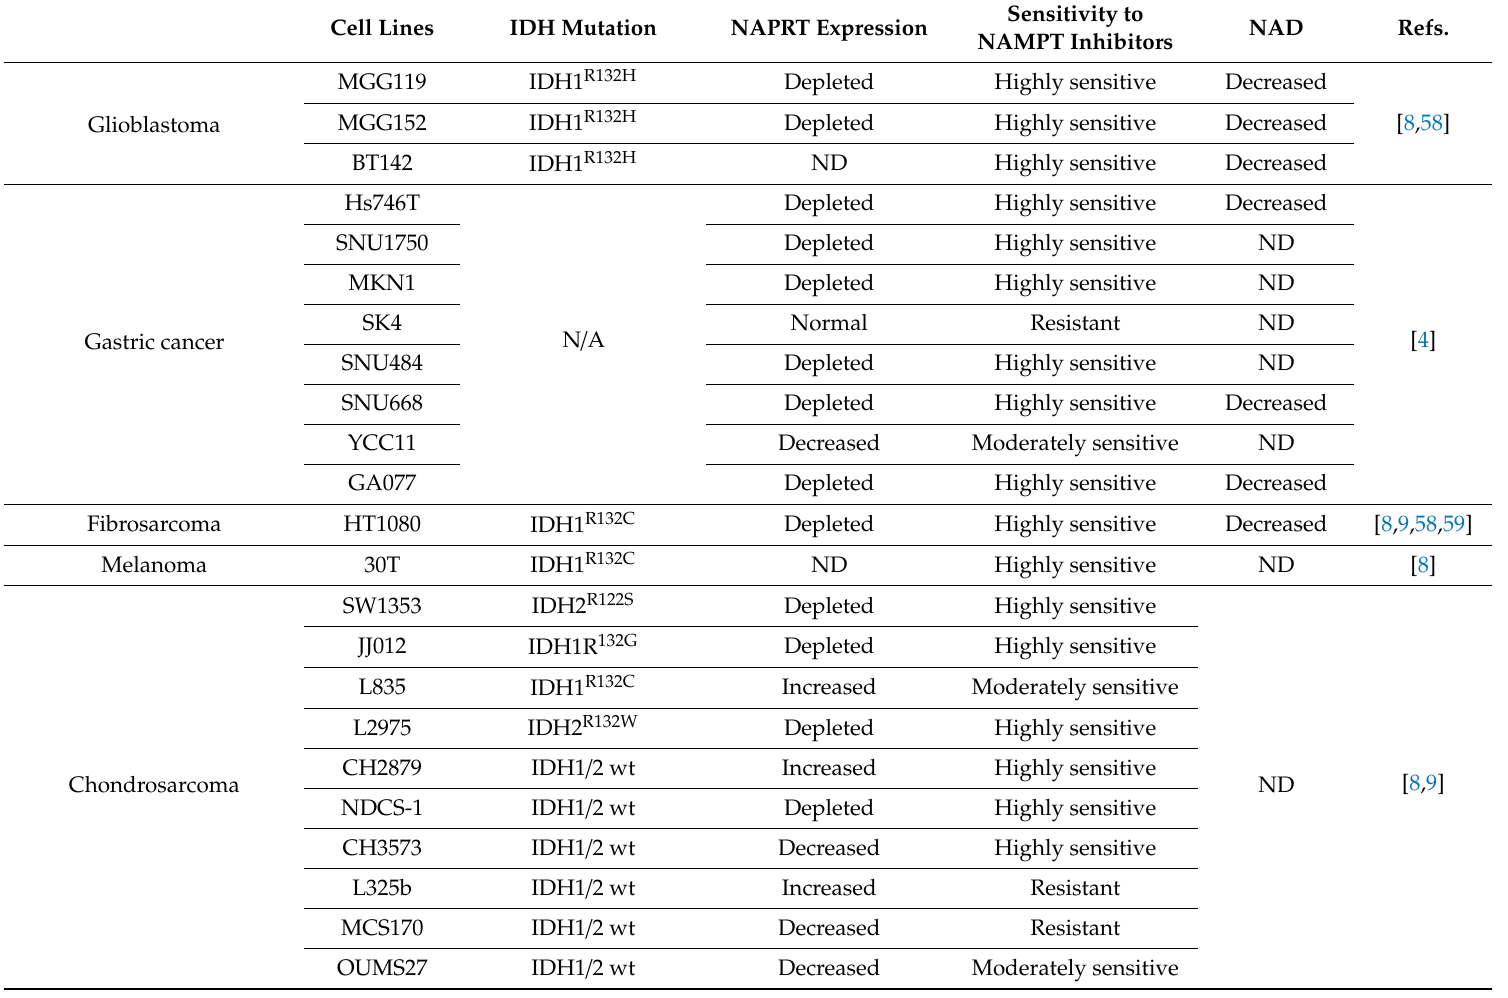
Table 1. Performance of NAMPT inhibitors in NAPRT-deficient / depleted cancer cell